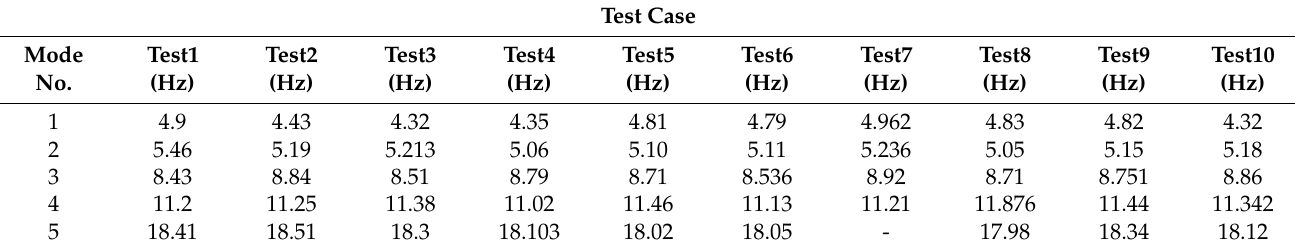
Table 3. Extracted damping ratios using the EFDD